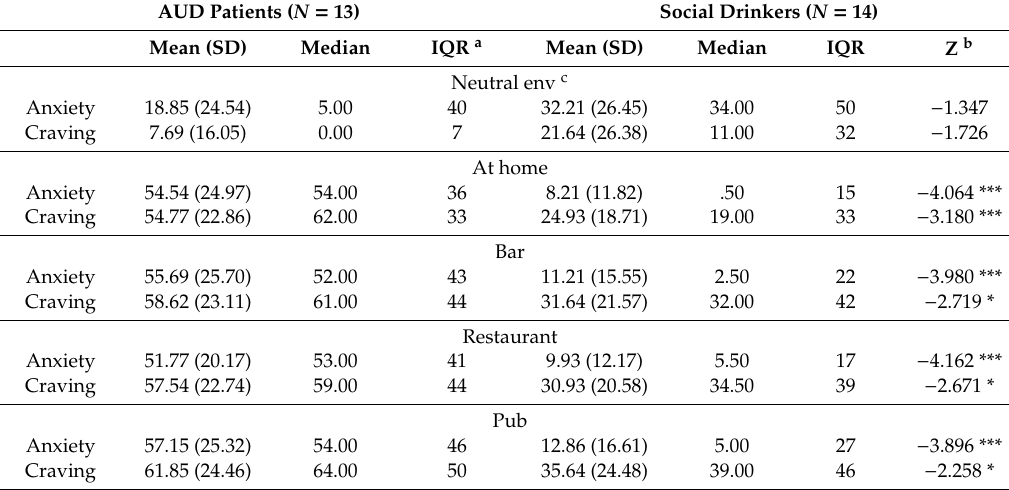
Figure 3. Self-reported mean levels of alcohol craving (C) on VAS-C. Table 2. Di ff erences in anxiety and alcohol craving self-reports on VAS-A and VAS-C. AUD Patients ( N =